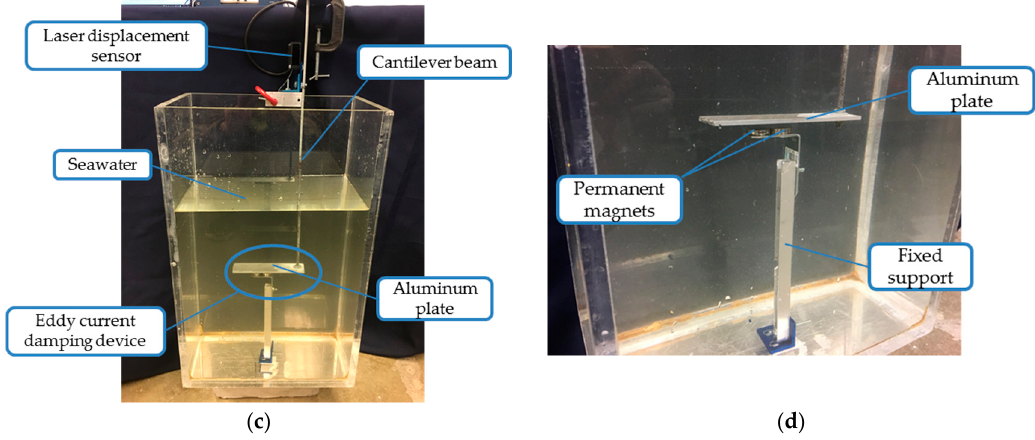
Figure 2. Experimental setup for free vibration tests: ( a ) global view; ( b ) side view of seawater container; ( c ) front view of seawater container; ( d ) eddy current damper.